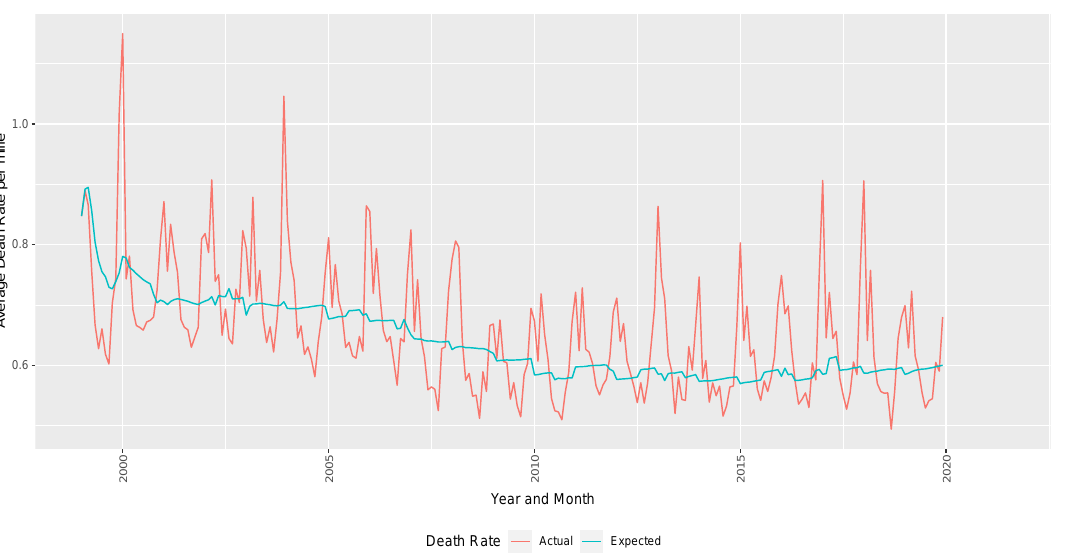
Figure 4. Death rate by year and month: Actual and